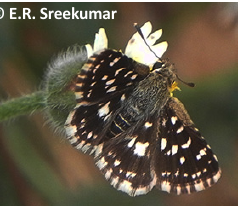
Image 44. Lime Blue Chalides lajus